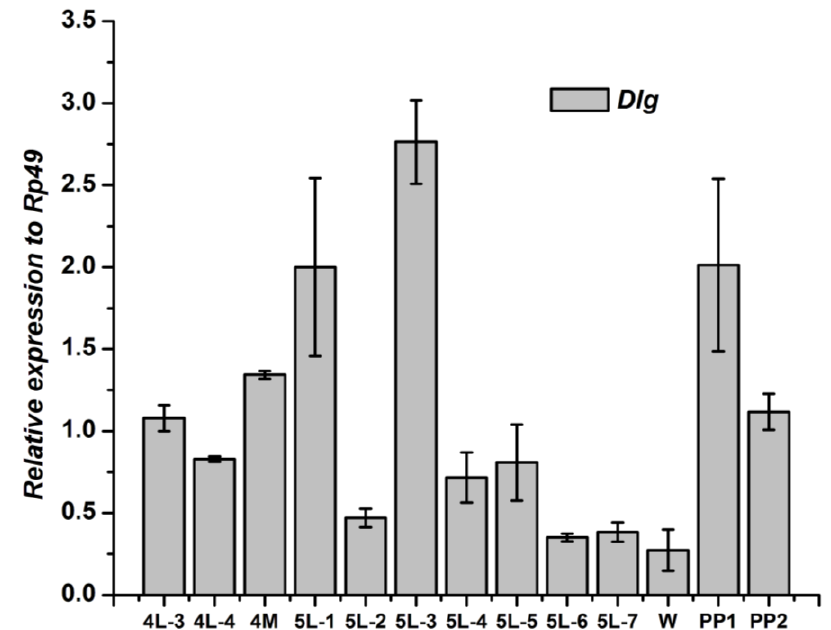
Figure 7. Developmental changes of Dlg mRNA in wingdisc of Bombyx